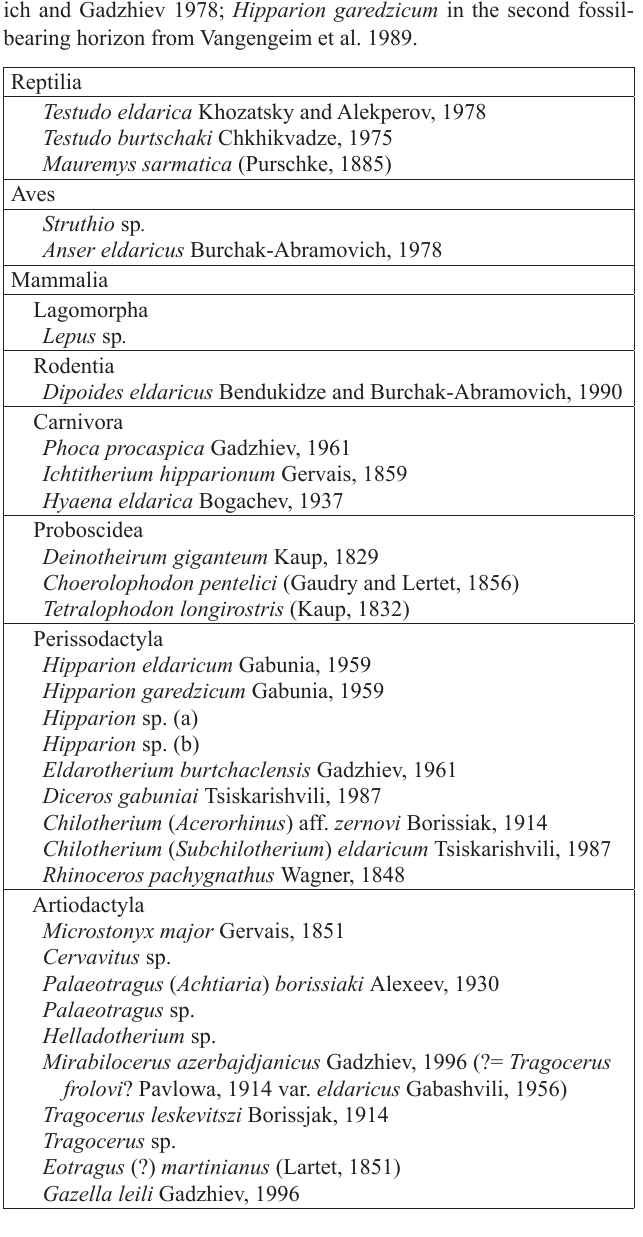
Table 2. Numbering of the lithostratigraphic units with fossil-bearing horizons of the Eldari site according to different